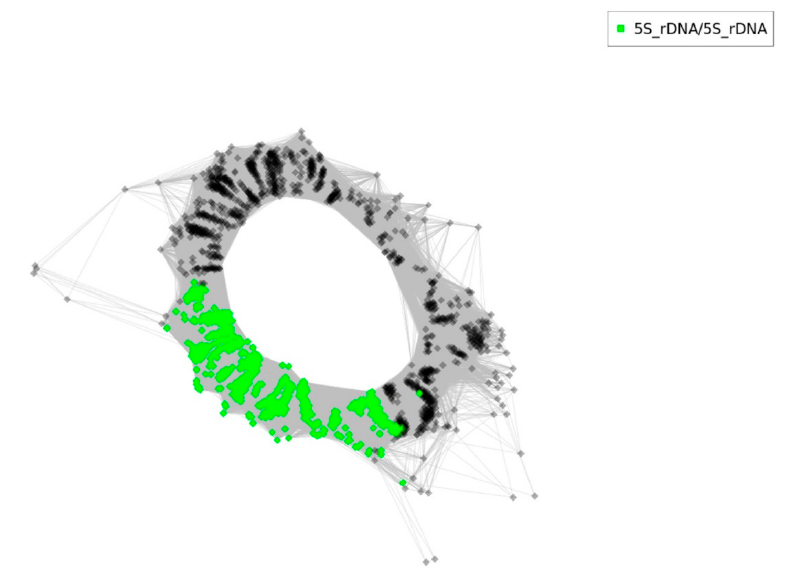
Figure 9. RepeatExplorer2 graphical output of T. medium 5S rDNA sequence reads cluster analysis. Nodes represent single reads. The intergenic spacers and 5S coding sequences are highlighted in grey and green, respectively.